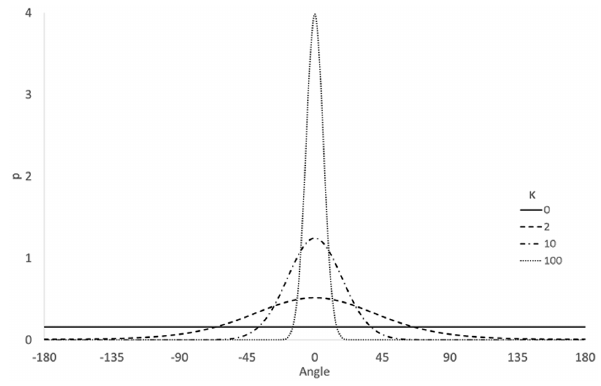
Figure 2. Von Mises–Fisher probability distribution function on S1 ( p = 2) for various concentrations κ . are not linearly correlated to κ . For example, the 95%